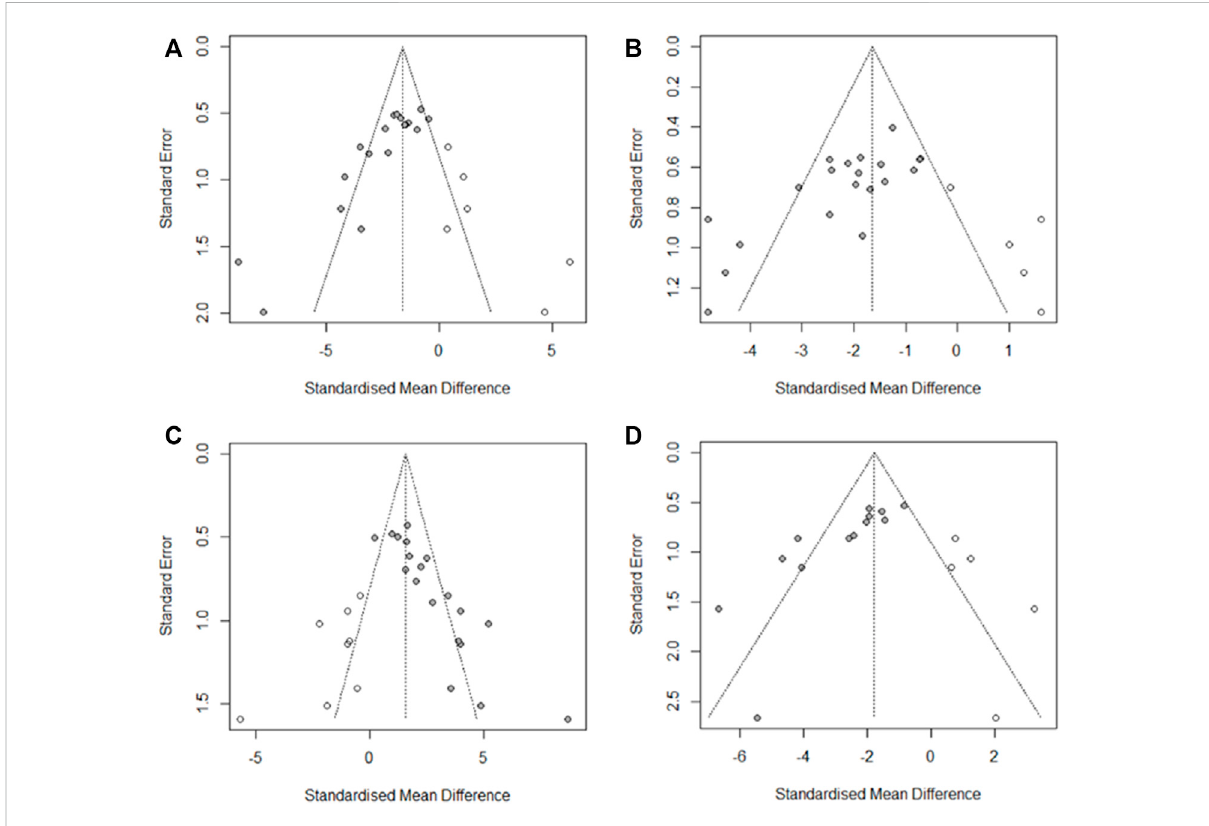
FIGURE 11 Results of trim and fi ll method. (A) DAI, (B) HCS, (C) CL, and (D)